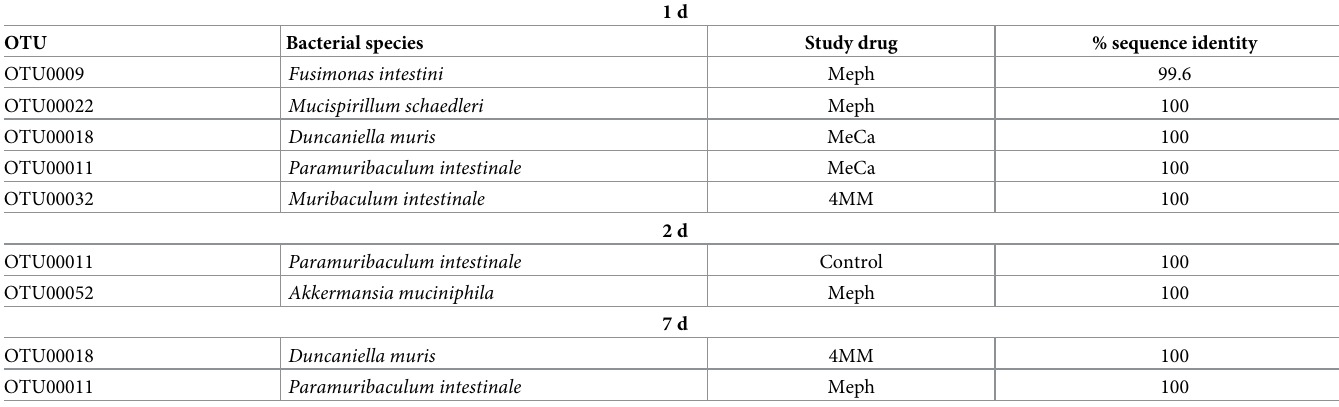
Table 1. BLAST analysis identifying individual bacterial species linked to specific study drugs.